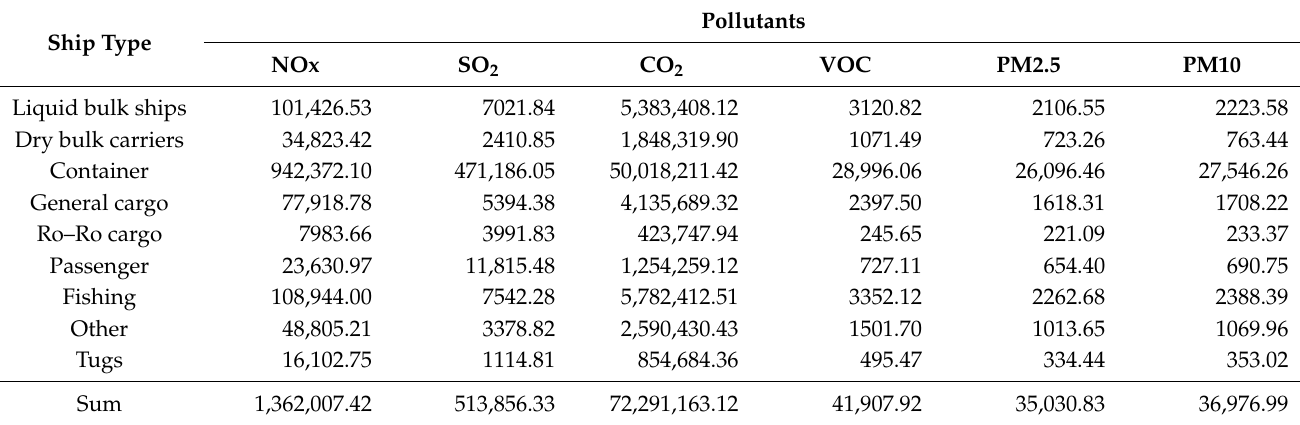
Table 10. Ship pollutant emissions by ship type at Busan Port in 2019 (ship activity phase: Hoteling) [kg].